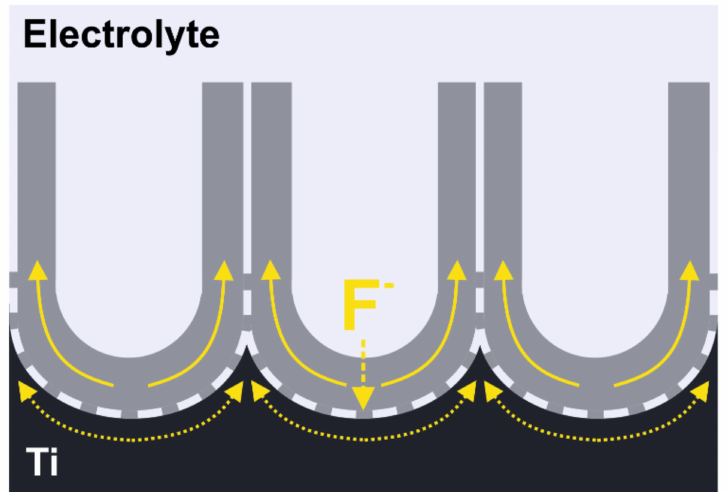
Figure 9. Conceptual representation of plastic flow of viscous oxide that leads to formation of nanotubular patterns during Ti anodization with